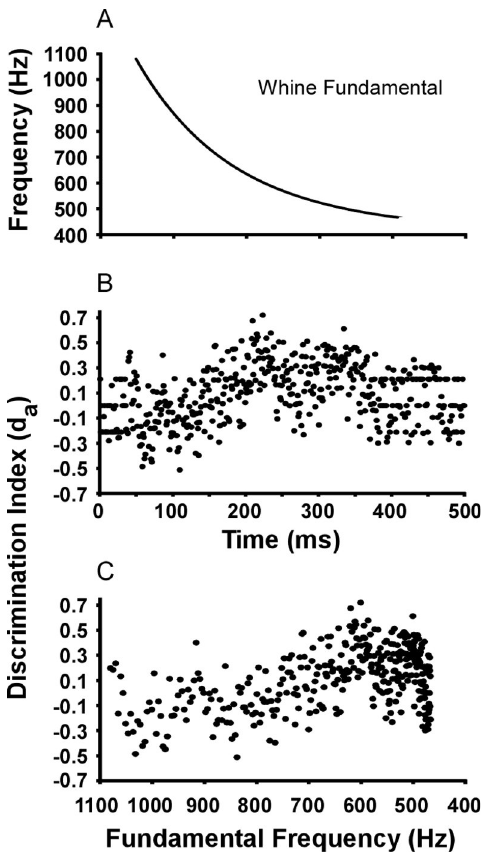
Fig 10. Whine versus noise ongoing discrimination index (d a ) as a function of time and whine fundamental frequency. (A) Fundamental frequency of the natural whine stimulus used in these experiments. (B) Ongoing discrimination index as a function of buffer time. (C) Same discrimination index after stimulus time was converted to whine fundamental frequency. Peak d a occurs as the fundamental passes through 601 Hz (calculated using 1 ms bin